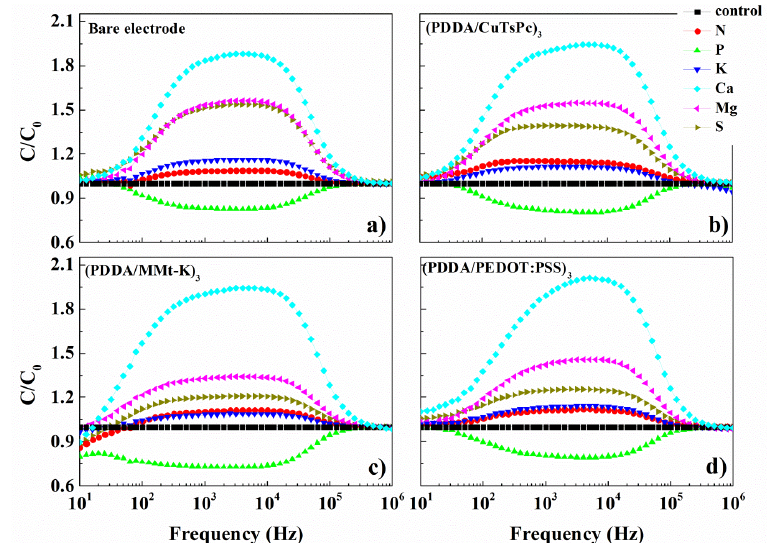
Figure 1. Relative capacitance (C/C 0 ) versus frequency for the soil samples in aqueous solutions using